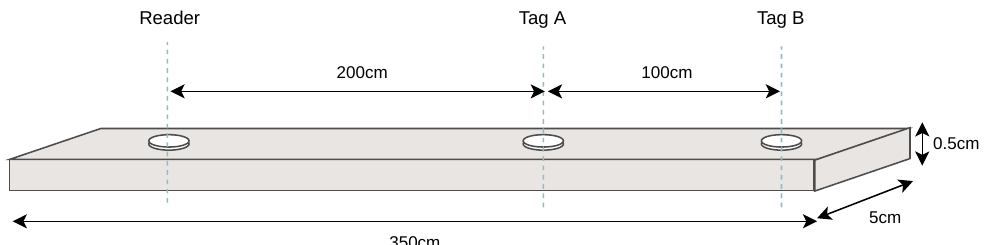
Figure 13. The evaluation setup on a 3.5 m steel beam (not to scale). We use two different channels with lengths: 2 m and 3